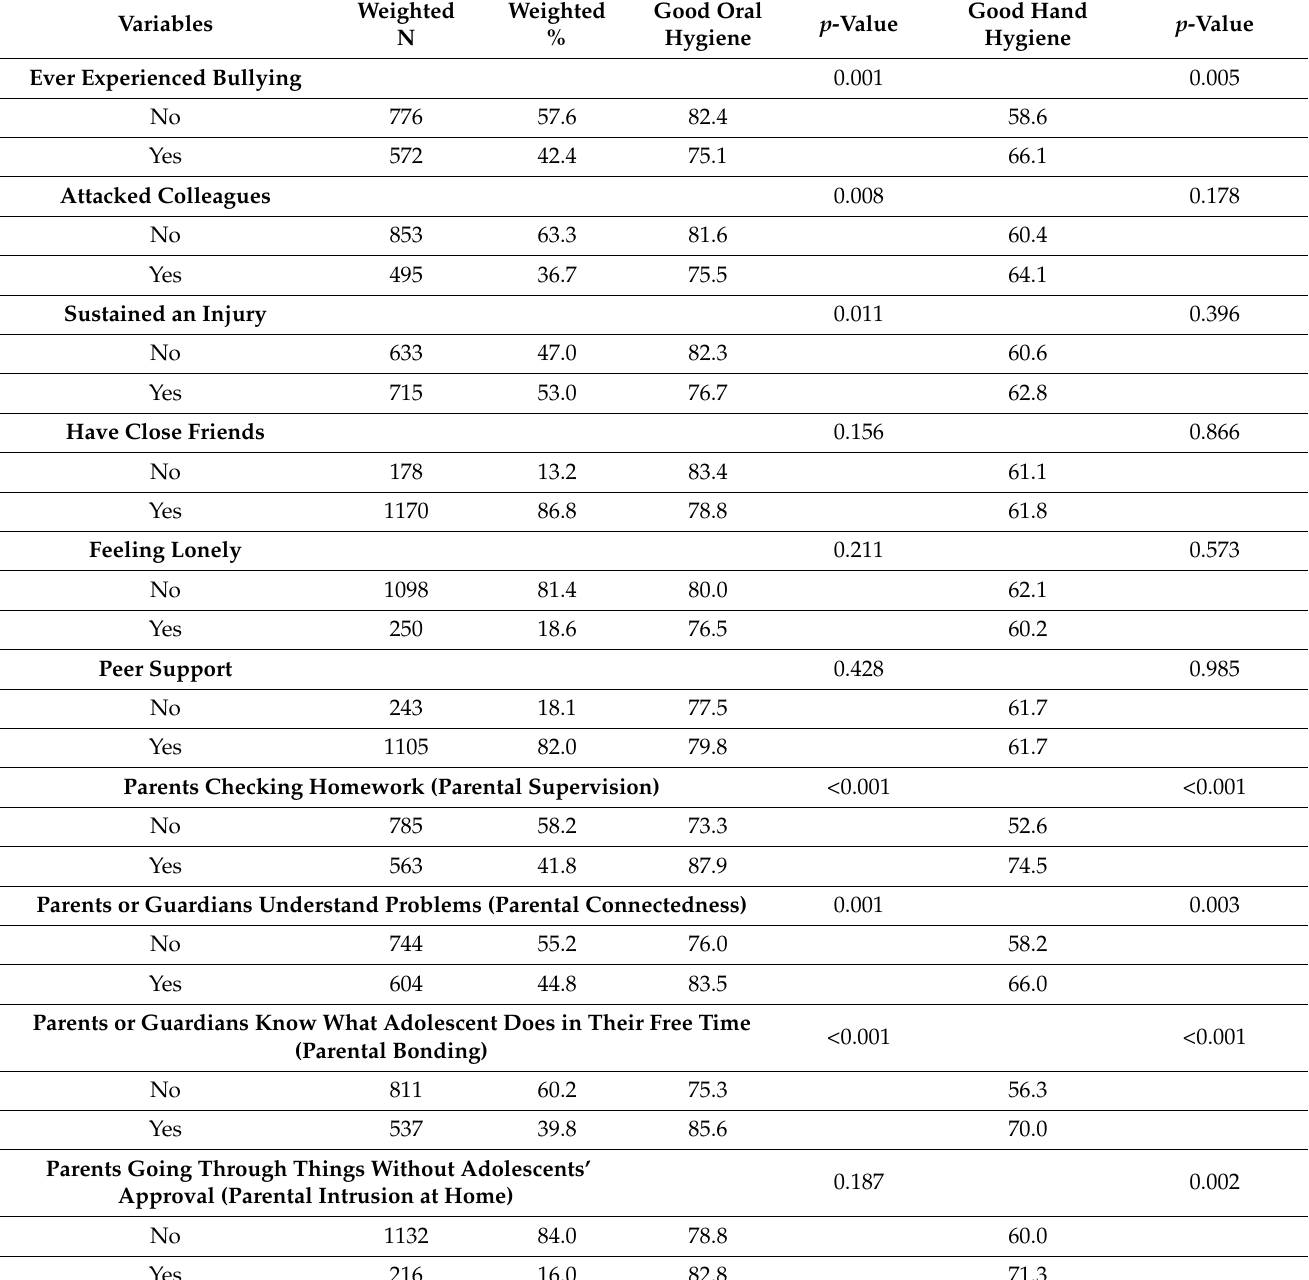
Table 3 represents the binary logistic regression models on the predictors of hand hygiene among in-school adolescents in Ghana. We found that truant adolescents